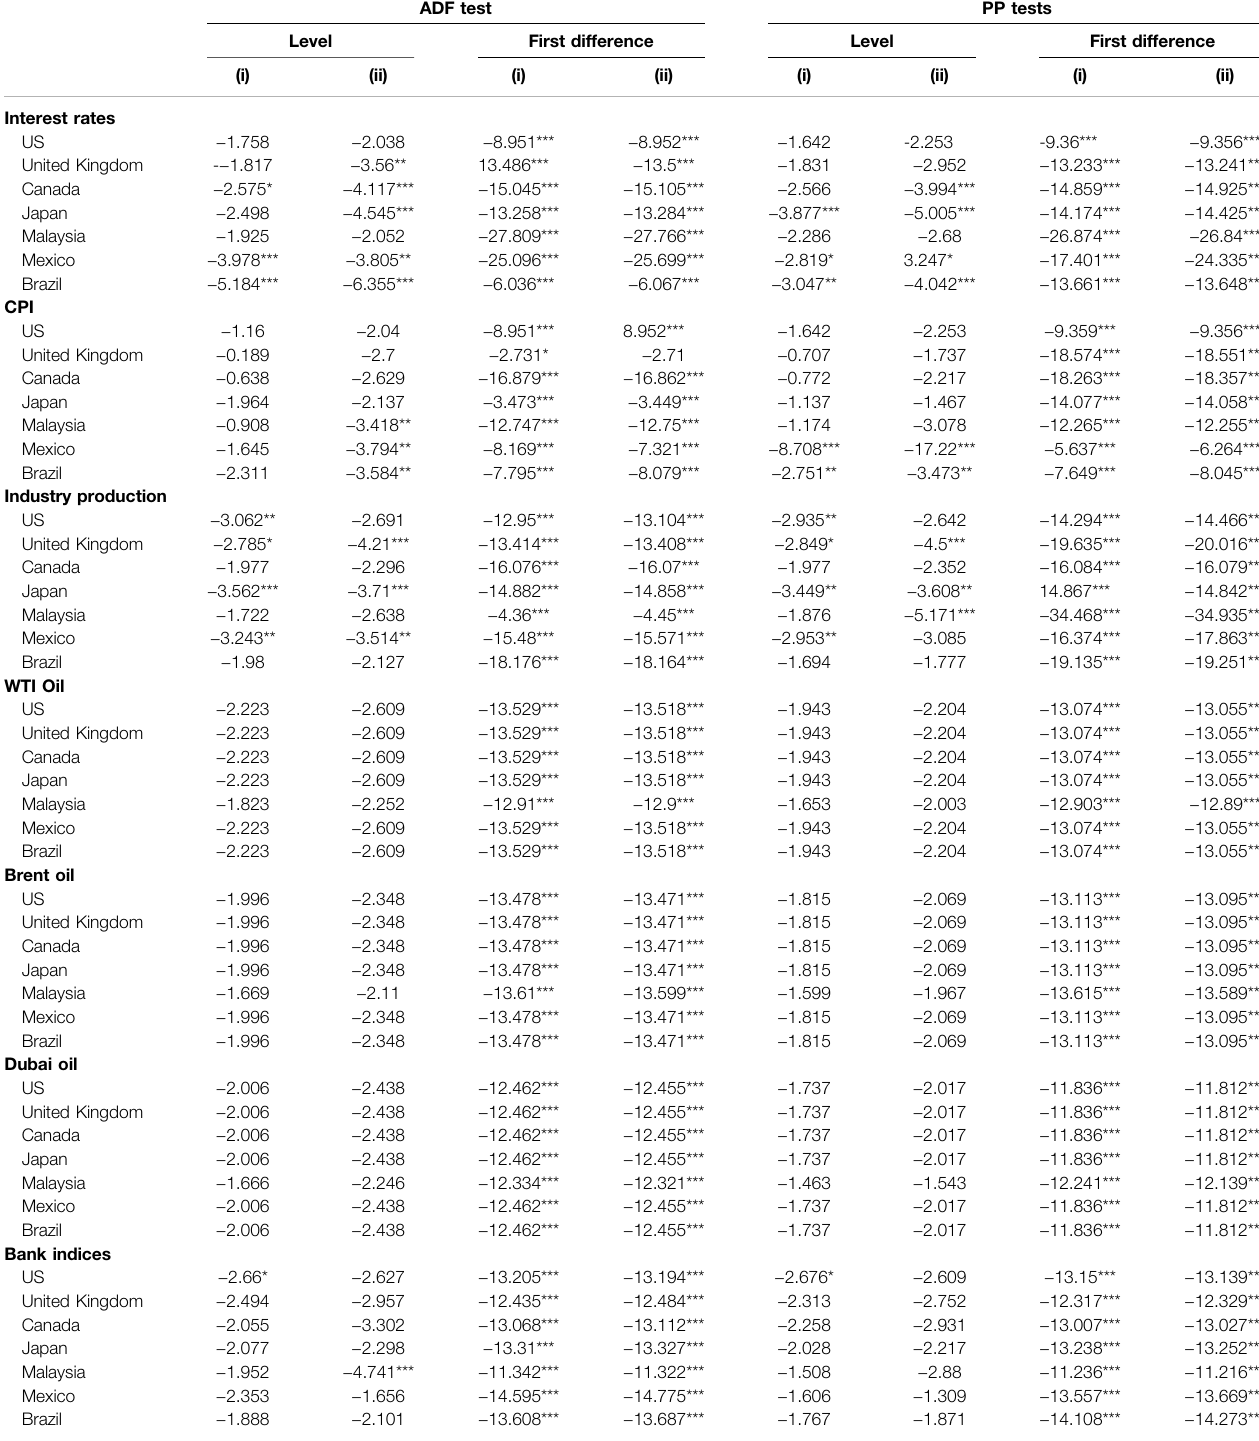
TABLE 3 | Unit root test